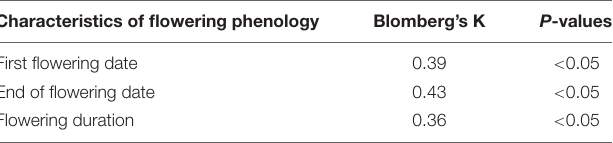
TABLE 2 | The values of Blomberg’s K of three characteristics of flowering phenology in 57 woody species.